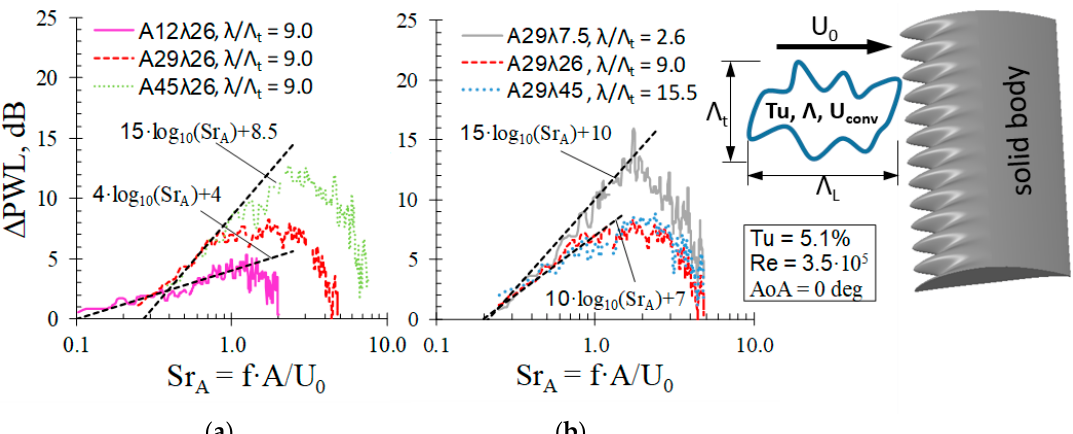
Figure 2. Spectral noise reduction (500 Hz ≤ f ≤ 5.8 kHz, 6th order median filtered) obtained from the 2D integration area. ( a ) Varying serration amplitude A; ( b ) Varying serration wavelength λ at Re = 350,000, AoA = 0 deg, aerofoil span S = 0.35 m, chord = 0.15 m. Figure adopted from [18].